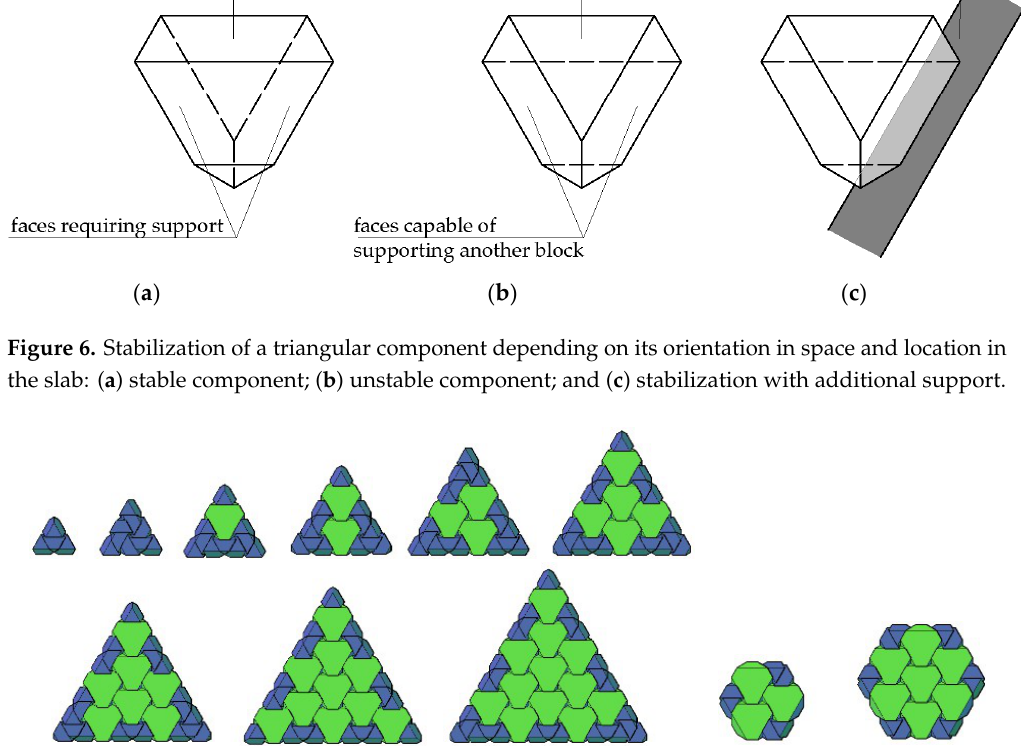
( b ) Figure 8. Hexagonal slabs composed of rhombic components: ( a ) joined three into hexagonal sets; ( b ) shaped analogically to a square vault. The alternative way of constructing hexagonal slabs consists in setting them together using components based on considering a rhombus as the sum of two equilateral triangles. Rhombic components can be combined into hexagonal assemblies—three pieces each [5]—from which larger structures can be created, or can be linked together similarly to square components. The first method is effective for hexagonal structures characterized by values of parameter n equal to 2 or 3 (Figure 8a); however, structures of any size can be created by use of the second method (Figure 8b). The assembly of structures from rhombic components requires the use of two types of such components, one according to Figure 5c and its symmetric mirror image. Mirror components are shown, in Figure 8, in a lighter color. Rhombic components can also be used in conjunction with triangular components. In such a way, both triangular and hexagonal structures can be aggregated. Each of the structures shown in Figure 6 can be replaced by a structure in which, instead of any hexagonal component, three rhombic components are used (Figure 9a,b). All the rhombic components forming a three-element system are identical. However, individual systems can be made of components compliant with that of Figure 5c, or of those formed by their mirror images. Another option is to construct structures by assembling them only from hexagonal- and rhombic-shaped components. This method is effective only for hexagonal structures characterized by values of the parameter n equal to 2 or 3 (Figure 10). The logical consequence is the possibility to use three types of components (i.e., hexagonal, triangular, and rhombic) into a single structure. This significant freedom in the selection of the configuration of the structure allows for differentiation of ornamentation on the surfaces of slabs of the same dimensions. The presentation of a wide range of structures differing in the configuration of elements is made below, with intention to compare the visual attractiveness of the ornaments on the upper and lower surfaces of the vault.